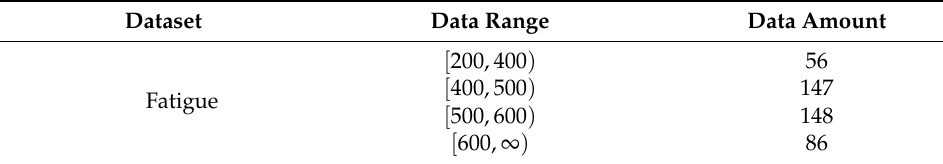
Table 2. Fatigue dataset for multi-classification tasks.